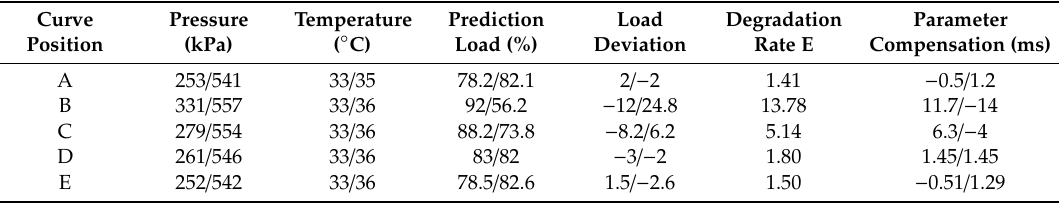
Table 7. Implementation optimization results of Experiment